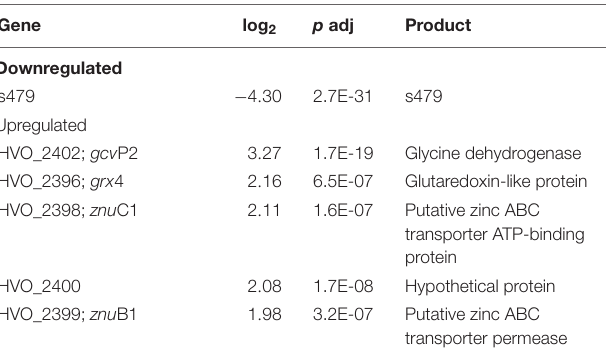
TABLE 1 | Six genes are differentially expressed in the deletion strain (cid:49) s479 . Gene log 2 p adj